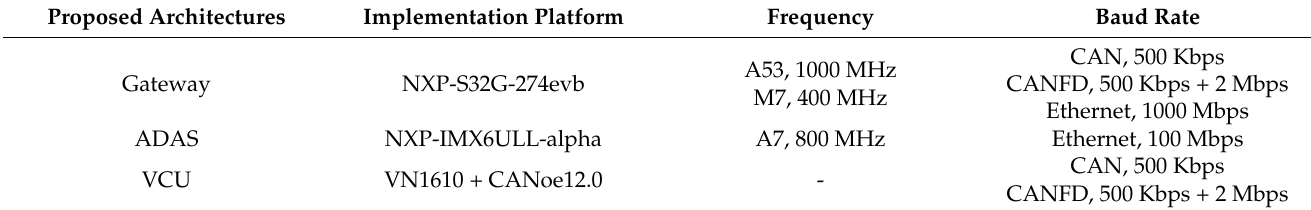
Table 4. Main components of the experimental environment.